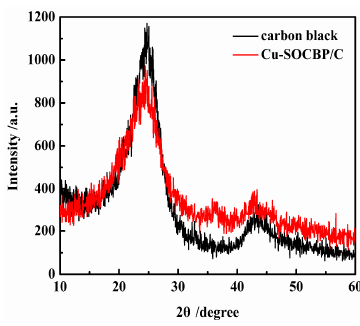
Figure 4. Powder X ‐ ray diffraction (XRD) spectra of carbon black and Cu ‐